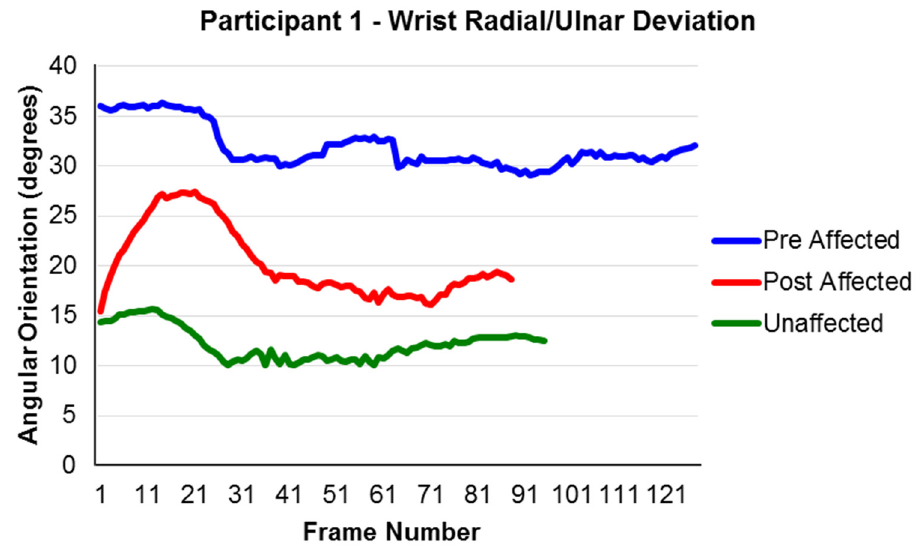
Figure 2. The Right Extended Forward Reach; (+) ulnar deviation and ( − ) radial deviation for Participant 1. Note: Frame number is a representation of time. The interval between frames was 1/60 th of a second. Participant 1 took longer to perform the reach prior to the intervention compared to after the intervention.